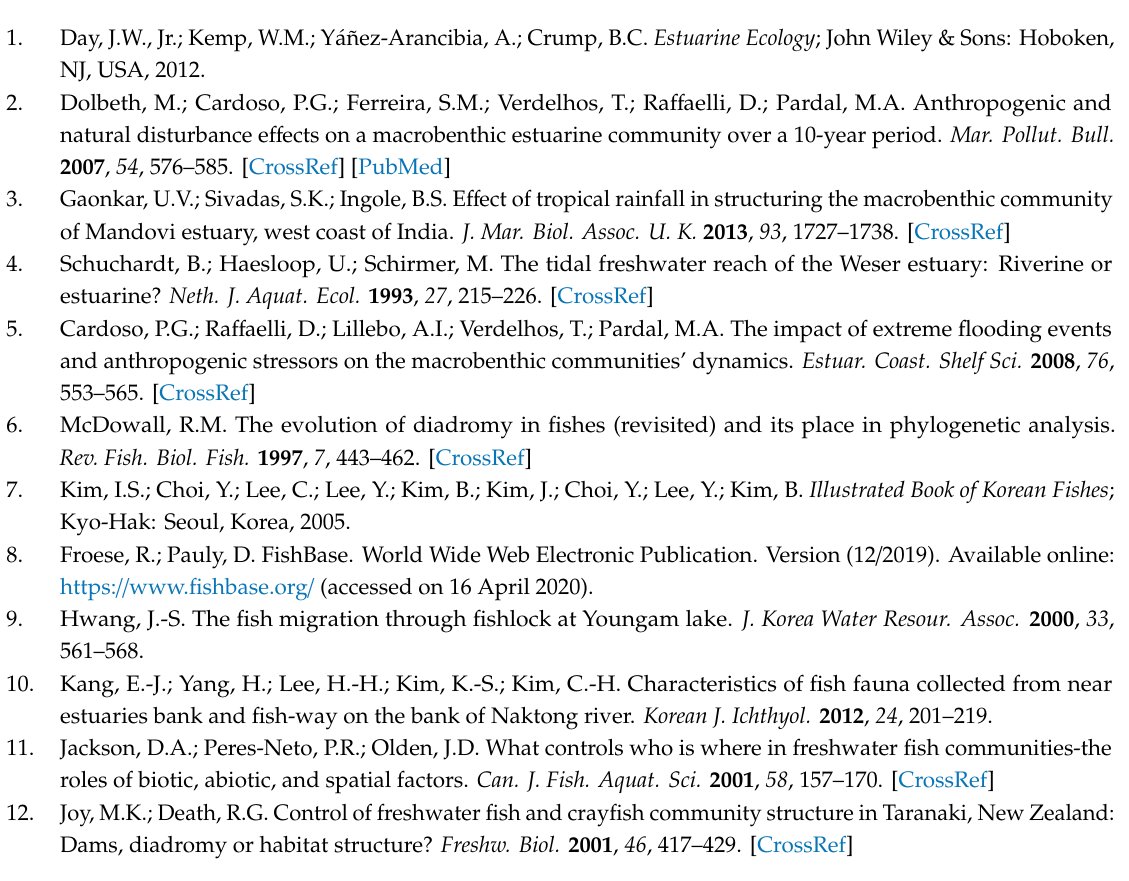
Table S1: List of species including Families, Scientific names, Common names and their abundances (N) in freshwater and estuary sites, and total abundance as well as percentages